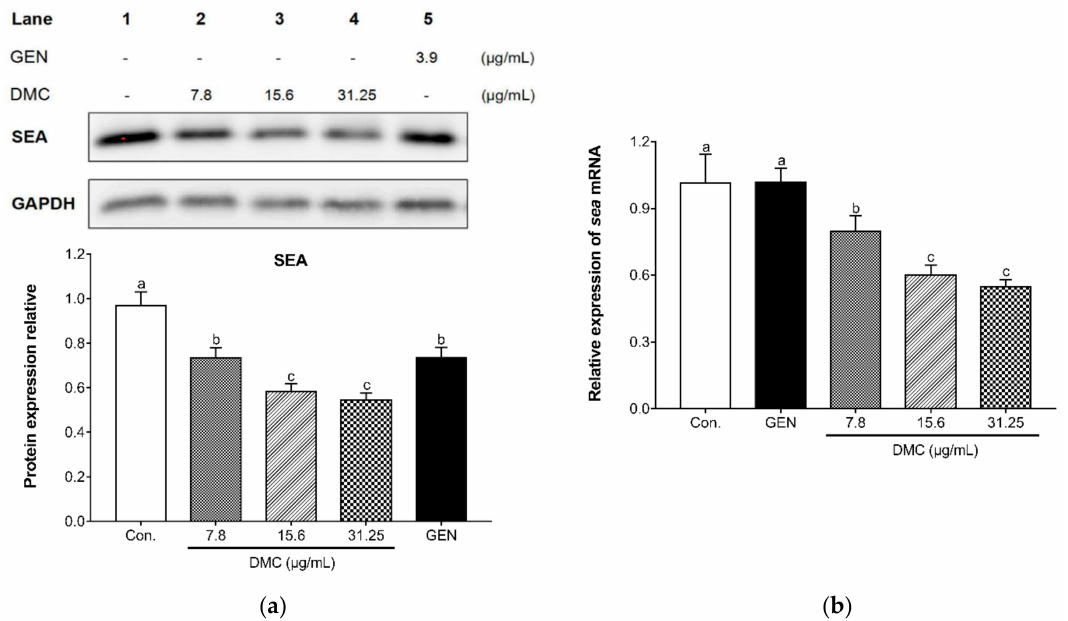
Figure 6. The effect of DMC on the protein ( a ) and mRNA ( b ) expression of staphylococcal enterotoxin A (SEA), as analyzed by western blot and qRT-PCR. ATCC 33591 were treated with serial dilution of DMC (7.8 µ g/mL, 15.6 µ g/mL and 31.25 µ g/mL) and GEN (3.9 µ g/mL). The data are means ± SD of triplicate determinations. Different letters in each bars indicate significant statistical differences between treatments ( p <